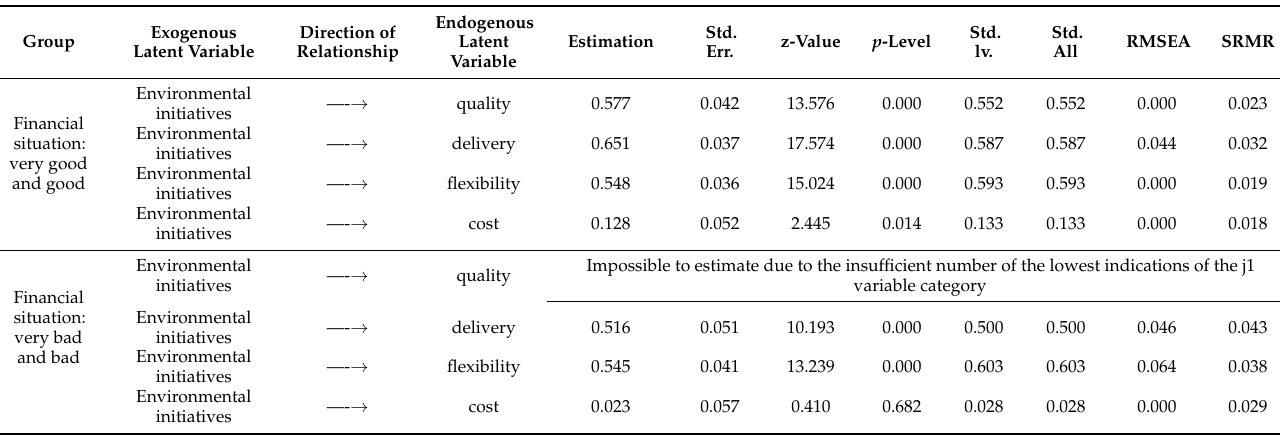
Table 3. Correlations between environmental initiatives and the factors of competitiveness according to the financial situation of